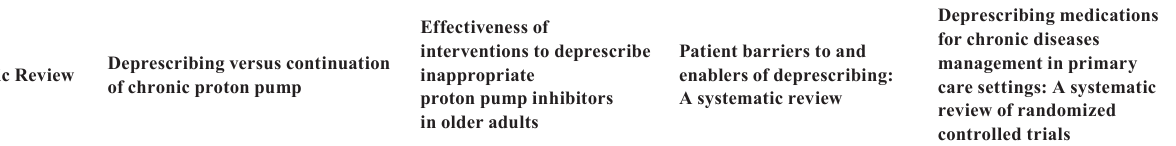
TABLE II - Characteristics of the included studies